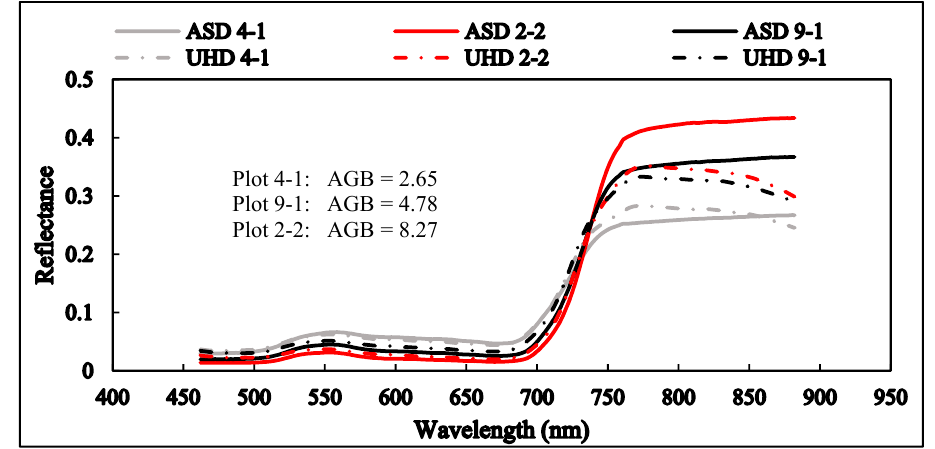
Figure 5. Canopy reflectance measured by the UHD 185 and ASD from 462–882 nm during the flagging stage. Grey solid and dashed lines represent the reflectance of Plot 4-1 measured by the ASD and UHD 185, respectively; black solid and dashed lines represent the reflectance of Plot 9-1 measured by the ASD and UHD 185, respectively; red solid and dashed lines represent the reflectance of Plot 2-2 measured by the ASD and UHD 185, respectively.